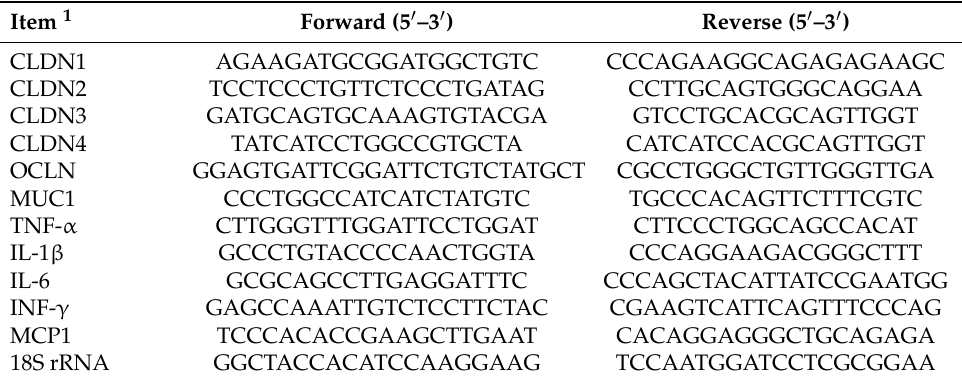
Table 2. Gene specific primer sequences for the gene expression of tight junction proteins and inflammatory cytokines in ileal